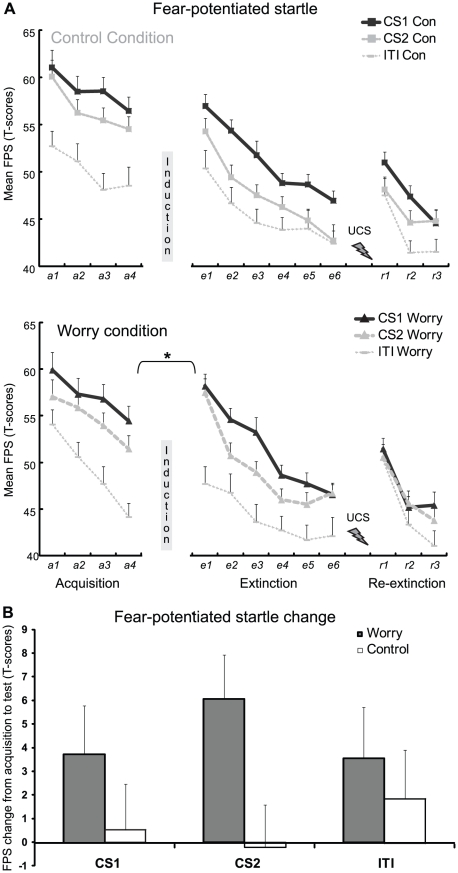
Worry manipulation after acquisition increases fear at test.A. Mean fear-potentiated startle (FPS; standardized T-scores) to the feared stimulus (CS1), safe stimulus (CS2) and during inter-trial intervals (ITI) during acquisition, extinction, reinstatement test and re-extinction for the Control condition (Con) and Worry condition separately. B. Mean change in startle responding to the feared stimulus (CS1), safe stimulus (CS2) and during inter-trial intervals (ITI) from the end of acquisition to test (start of extinction) for the Worry and Control condition (Con). Induction: worry or control manipulation; UCS with Flash: electric stimulus administered during reinstatement; Error bars reflect SEM.